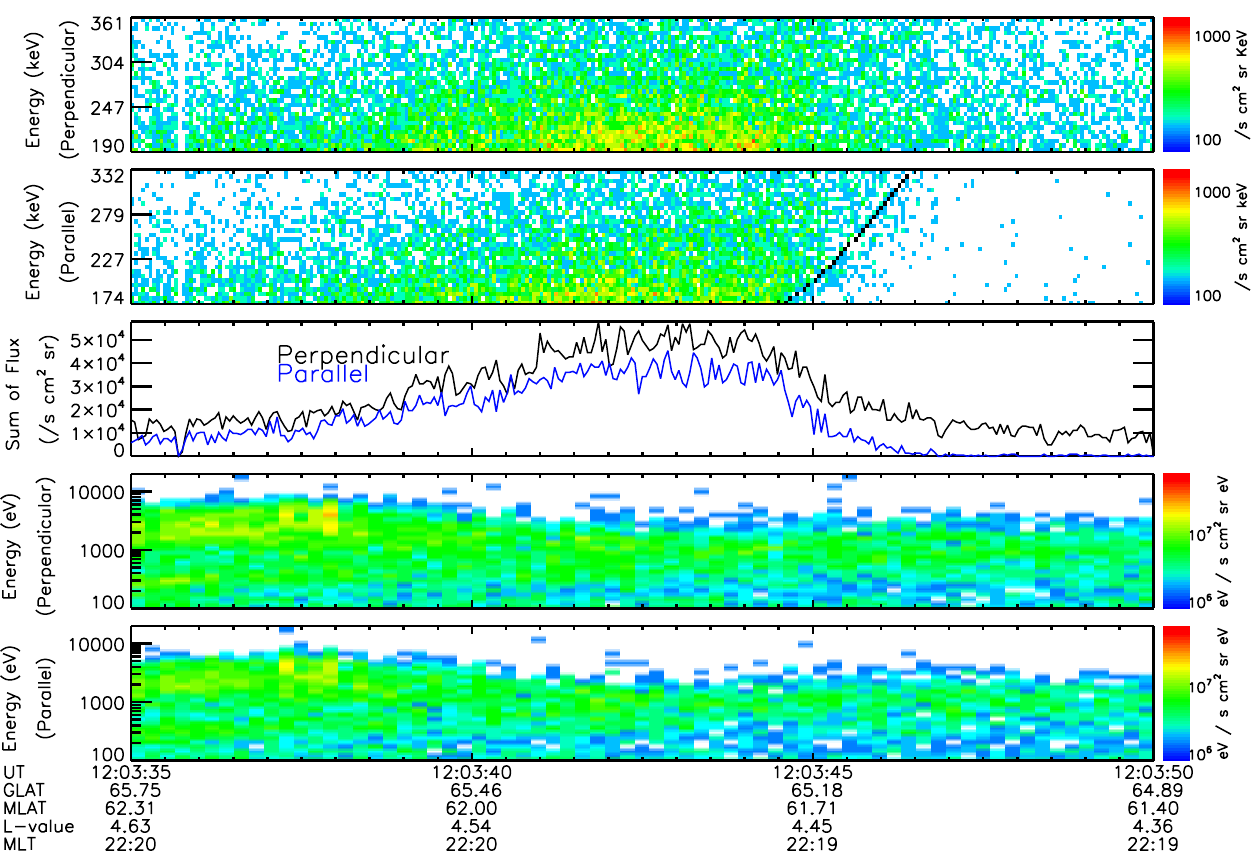
Fig. 6. Energetic electron precipitations observed by STSAT-1 on 14 June 2004. The black line in the second panel indicates energy dispersion calculated in Fig.